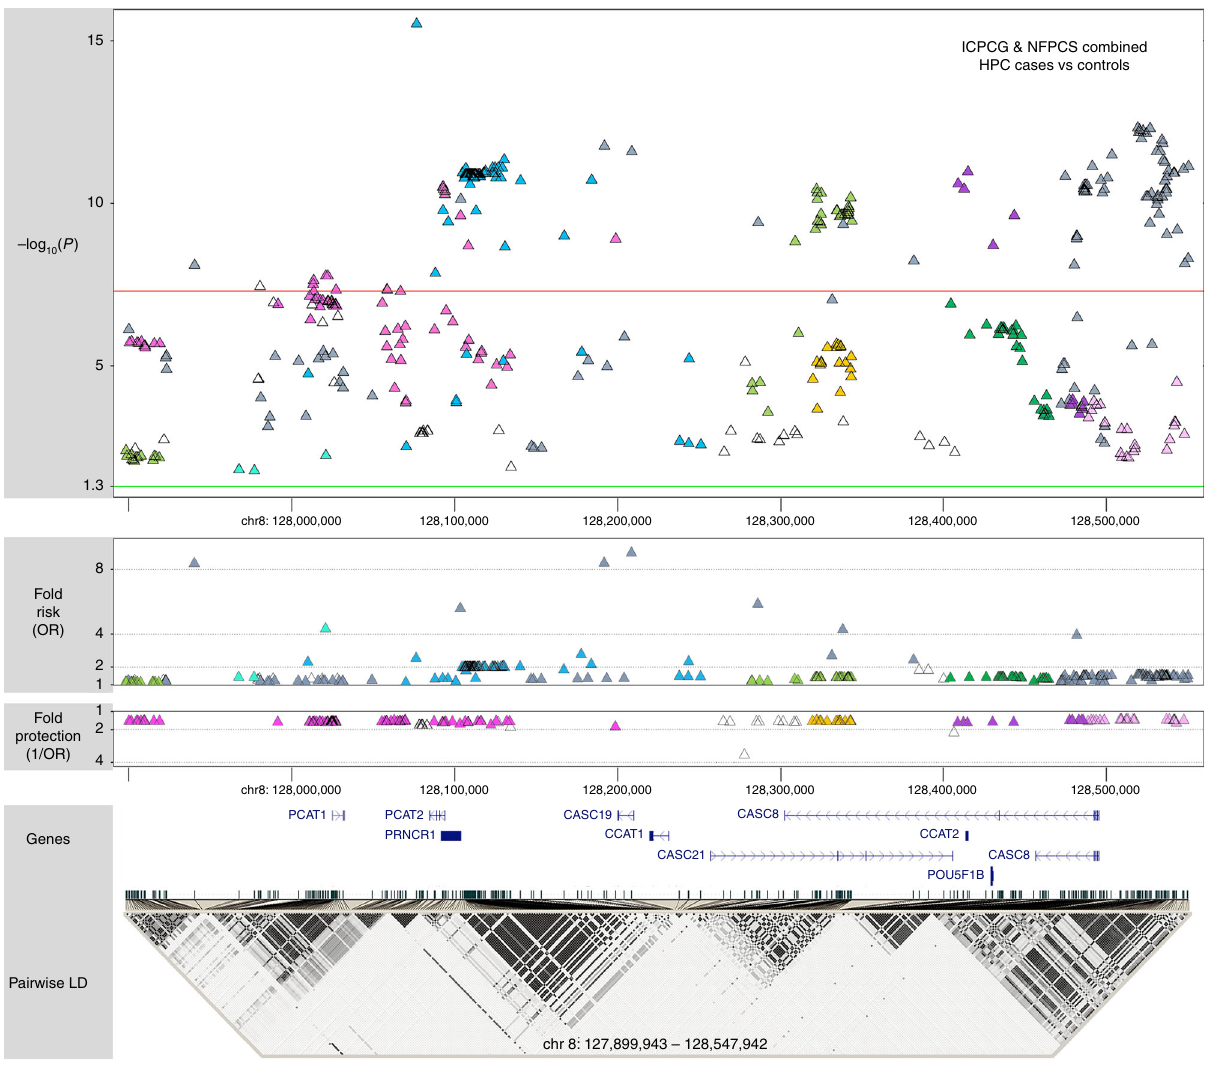
Fig. 2 Association of 433 concordantly signi fi cant 8q24 genetic variants with HPC in combined NFPCS and ICPCG subjects. Each variant is color-coded to delineate the corresponding risk-altering haplotype marked by its minor allele (haplotypes are separately depicted in Fig. 3 and Supplementary Fig. 2). At top is a Manhattan plot of the combined study populations depicting variant positions on the x -axis and − log 10 P values on the y -axis. The horizontal red line corresponds to the genome-wide signi fi cance threshold of P = 5 × 10 − 8 to accommodate multiple comparisons; the green line to P = 0.05. Each data point depicts the result of a multiplicative logistic regression model (additive genetic model), with two-sided signi fi cance assessed using Wald tests. The middle plot displays corresponding effect sizes, either risk or protective. At bottom is a map of regional genes (UCSC hg19), and a pairwise LD matrix depicting R 2 values among HPC cases of the combined studies. Source data are provided in Source Data fi le tab 1.